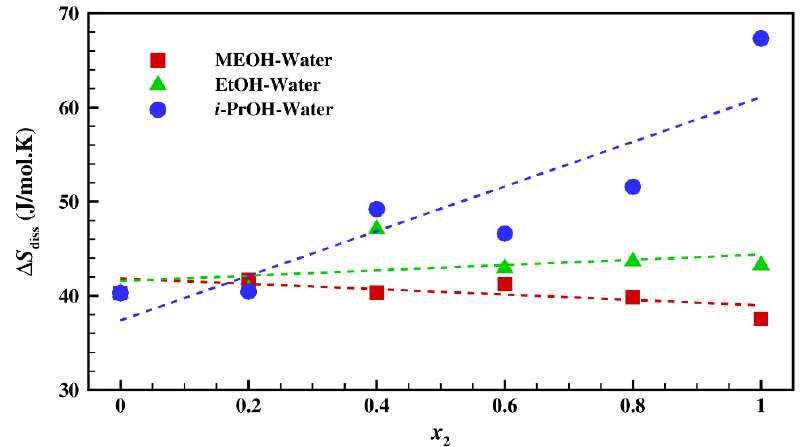
Figure 8. Change in dissolution entropy with alcohol composition in binary solvent systems. Symbols: Enthalpy using Van’t Hoff (Equation (11)); Dotted lined: Entropy using Jouyban-Acree model (Equation (14)).